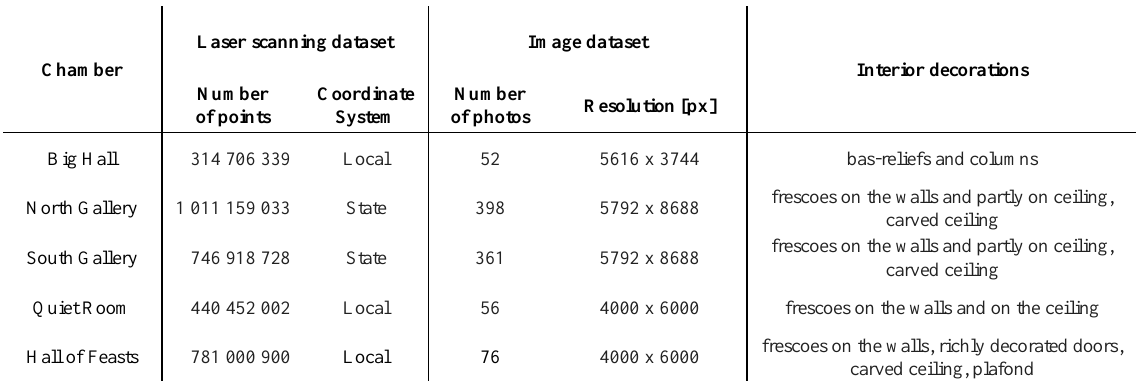
Table 1. Data used to model the room with their description of the